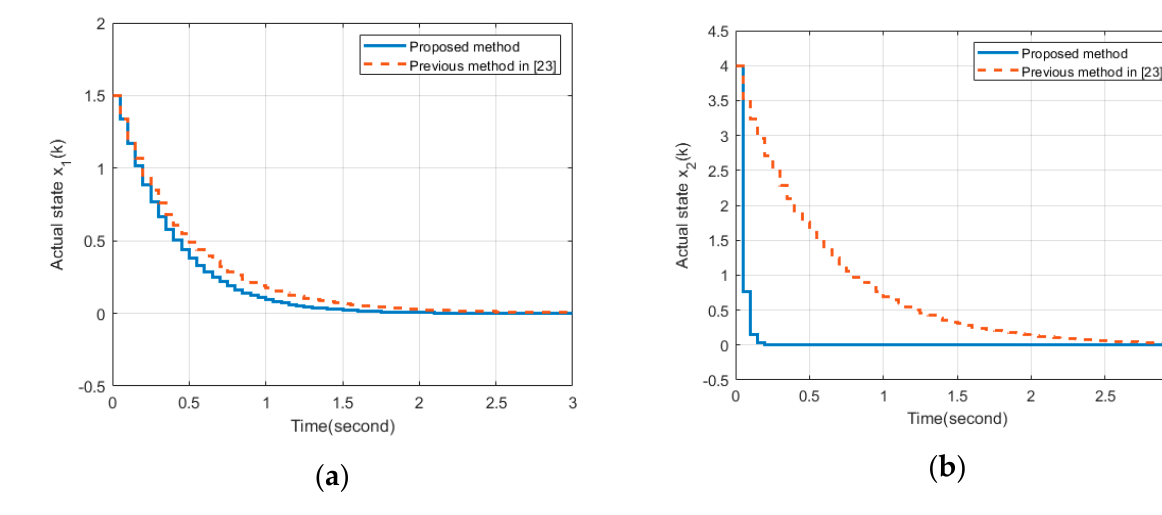
Figure 3. ( a ) The comparisons of x 1 ( k ) ; ( b ) The comparisons of x 2 ( k ) ; ( c ) The comparisons of x 3 ( k ) .